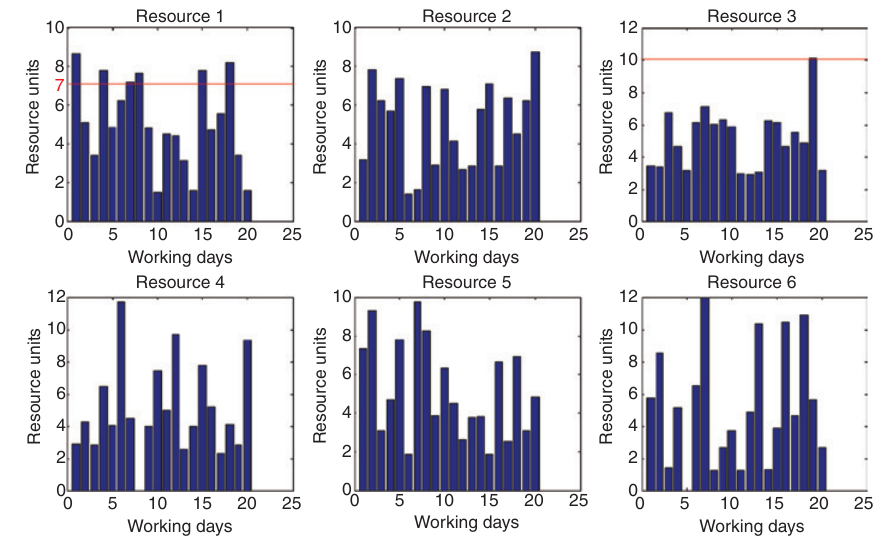
Figure 12: Resource Utilization with MOPSO.